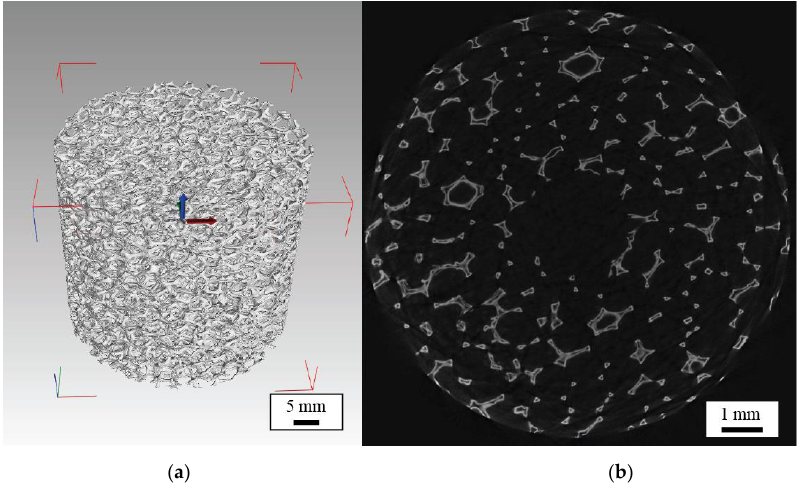
Figure 4. Sample of the metal foam used in high-resolution X-ray microtomography, 3D model ( a ) and X-ray scan of one layer ( b ). Table 2. Detailed parameters of X-ray scanning.